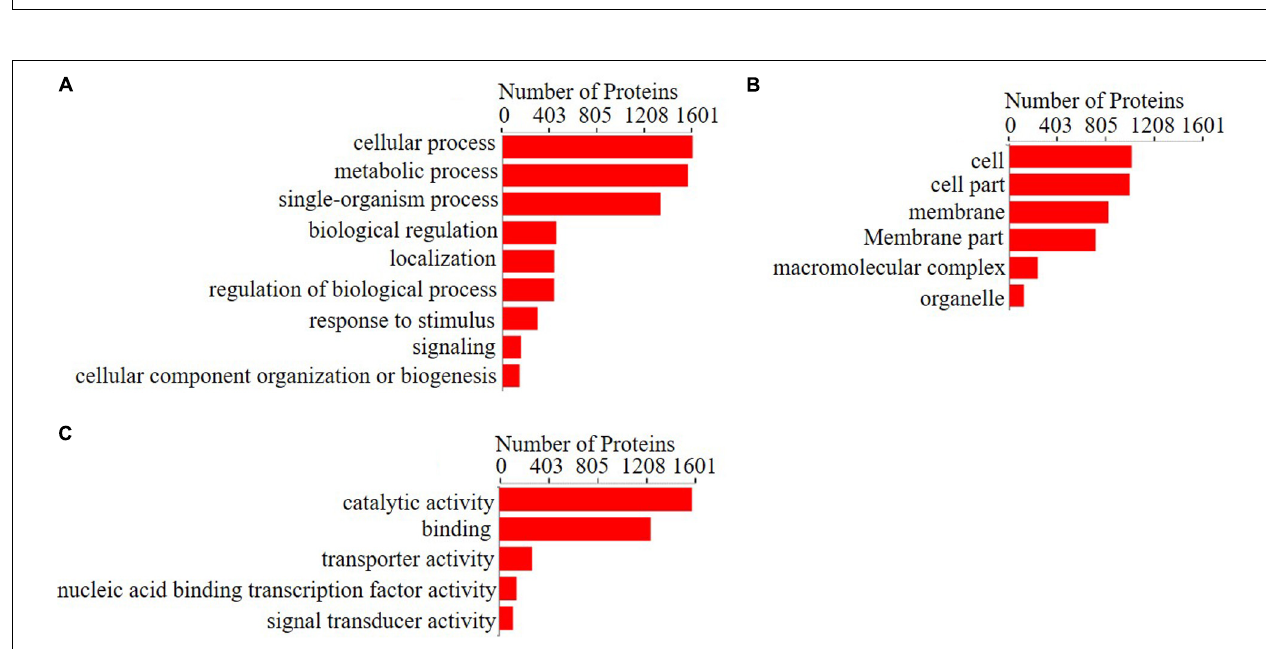
FIGURE 4 | Gene ontology (GO) analysis for the proteins that changed significantly between the treatment group and the control group. Gene ontology enrichment analysis of (A) biological process, (B) cellular components, and (C) molecular functions for regulated proteins with fold change > 2 or < 0.5 with p -value < 0.05. Blast2GO version 5 was used for functional annotation, and GOATOOLS was used to perform GO enrichment analysis.